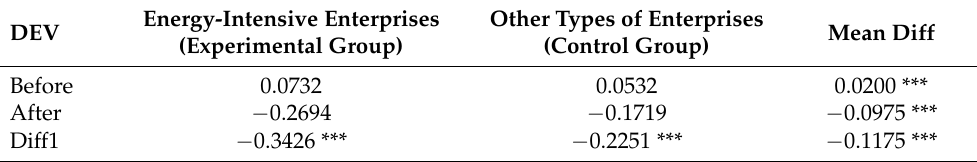
Table 6. Univariate difference-in-differences estimation